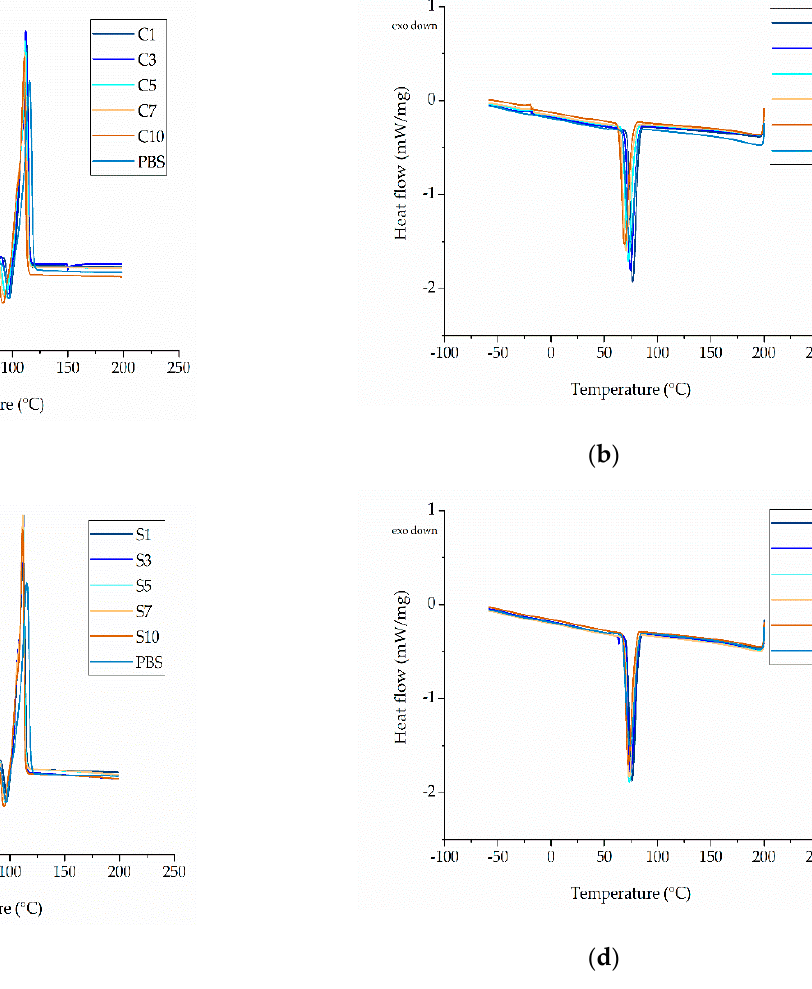
Figure 8. DSC thermogram of PBS compounds. ( a ) Heating cycle of PBS and PBS-curcumin com- pounds. ( b ) Cooling cycle of PBS and PBS-curcumin compounds. ( c ) Heating cycle of PBS and PBS-silver compounds. ( d ) Cooling cycle of PBS and PBS-silver compounds.